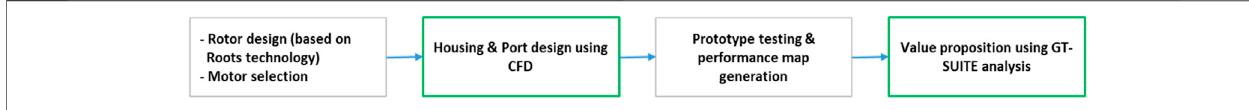
FIGURE 2 | Flowchart of the EGR pump development